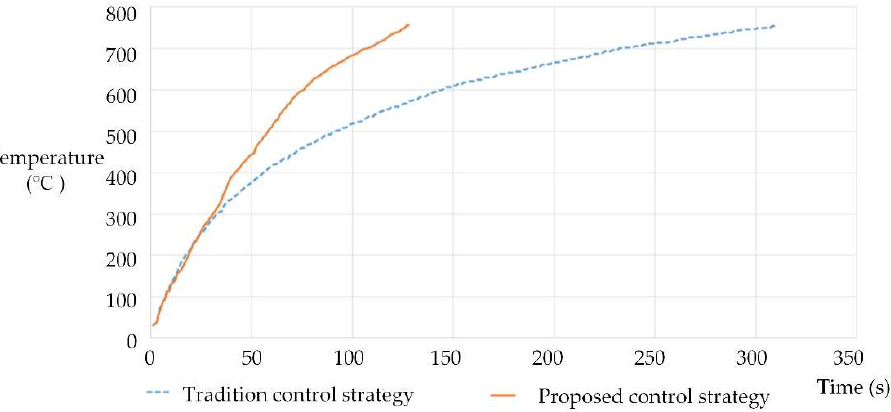
Figure 24. Comparison of the traditional control strategy and proposed MPPT heating control strategy for the heating duration of the proposed induction heating system.